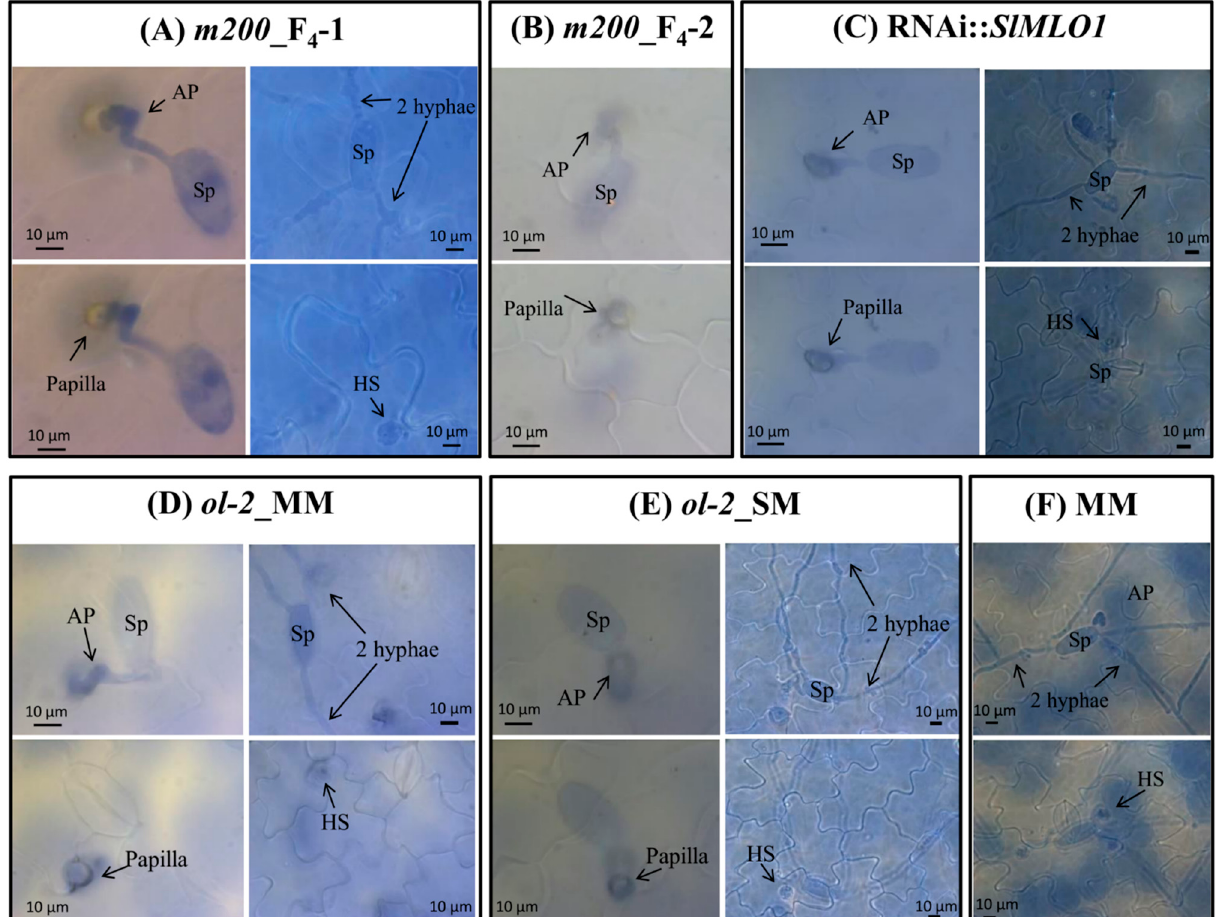
Figure 4. Microscopic observations on powdery mildew infection and development of the infection units (IU) of Oidium neolycopersici on six different genotypes. In each panel photos are taken from ( A ) and ( B ) F 4 plants carrying the m200 allele, ( C ) a plant carrying the RNAi:: SlMLO1 construct, ( D ) and ( E ) plants carrying the ol-2 allele in Moneymaker (MM) and Super Marmande (SM), ( F ) MM, respectively. Photos of two IU/genotype are shown, except for the MM and F 4 -2 carrying the m200 allele where only one IU is shown. Each photo is taken with different focus to observe all the fungal structures and papillae, from the most superficial to the deepest ones. Sp = spore, AP = appressorium; HS = haustorium; 2 hyphae = secondary hyphae. Table 1. Oidium neolycopersici development 72 h after the artificial inoculation. Approximately 100 infection units (IU = fun- gal spore producing a germination tube) per genotype were observed and the number of papillae and haustoria were counted. Subsequently, the percentage of IU showing a papilla or haustorium was calculated. Genotype